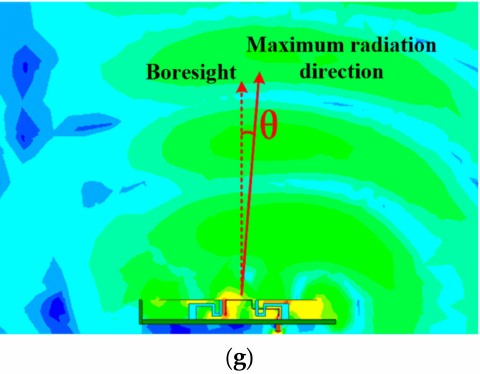
Figure 6. The structure of the antenna with ( a ) two symmetric vertical walls; ( b ) only flat ground plane; ( c ) one vertical wall; ( d ) the VSWR for different ground; ( e ) the radiating E field at 2.2 GHz for antenna 1; ( f ) the radiating E field at 2.2 GHz for the antenna with the single vertical wall on the left side; ( g ) the radiating E field at 2.2 GHz for antenna 3.